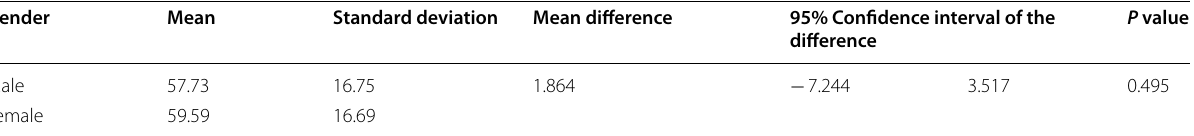
Table 2 Average age comparison among sex of patients with acute unilateral lower limb swelling